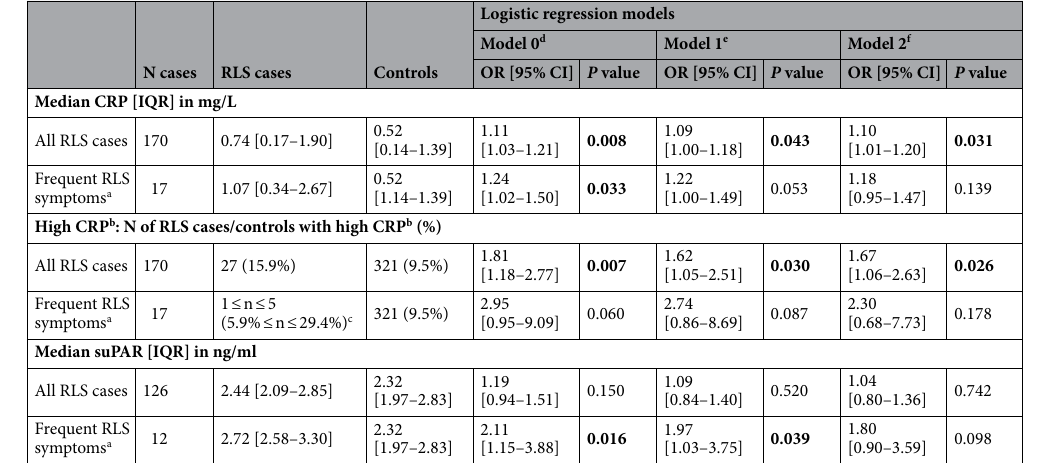
Table 2. Chronic inflammation in RLS. Table reports the number and proportion of RLS cases (including those reporting frequent RLS symptoms) and controls with median CRP levels, high CRP levels, and the median suPAR levels in RLS cases and controls. Results from the logistic regression models are also presented using CRP and suPAR levels as the independent variable and RLS status as the dependent variable in the DBDS cohort with available CRP data (N = 3564) and suPAR data (N = 2546). IQR interquartile range, OR odds ratio, CI confidence interval. a Cases with frequent RLS symptoms are classified as having symptoms occurring 2–3 times a week or more. b High CRP is classified as having hsCRP levels above 3 mg/L but below 10 mg/L. c N cases with frequent RLS symptoms and with high CRP are less than or equal to 5. Local data confidentiality protection policies prohibit the exact reporting of observations ≤ 5. d Model 0 = Crude association. e Model 1 = adjusting for sex and age. f Model 2 = adjusting for sex, age, smoking status and BMI. Significant values are in